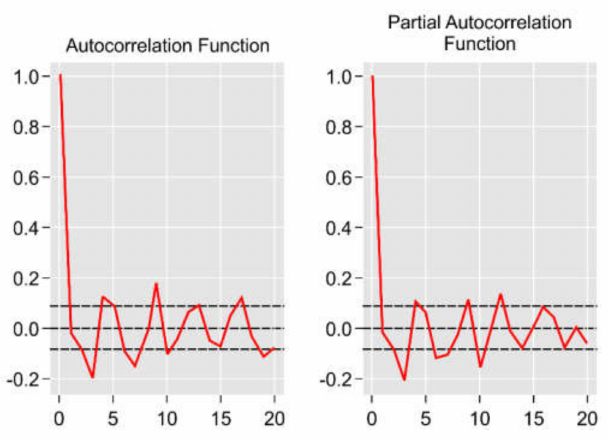
Figure 3. ACF and PACF.